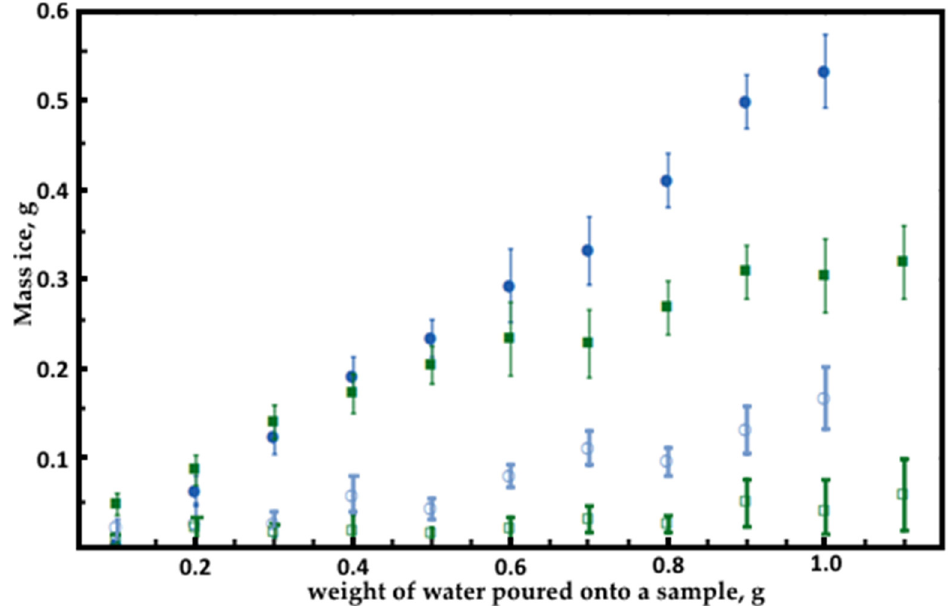
Figure 6. Icing mass on samples depending on the amount of water poured onto them. Filled marks signify steel samples; empty marks denote samples with coatings of xerogel based on Taunit-MD and ethanol (with a fraction of 0.125–0.100 mm). Blue marks correspond to samples cooled down to − 15 ◦ C, green marks represent samples cooled down to − 5 ◦ C. The data presented are an average of three measurements.